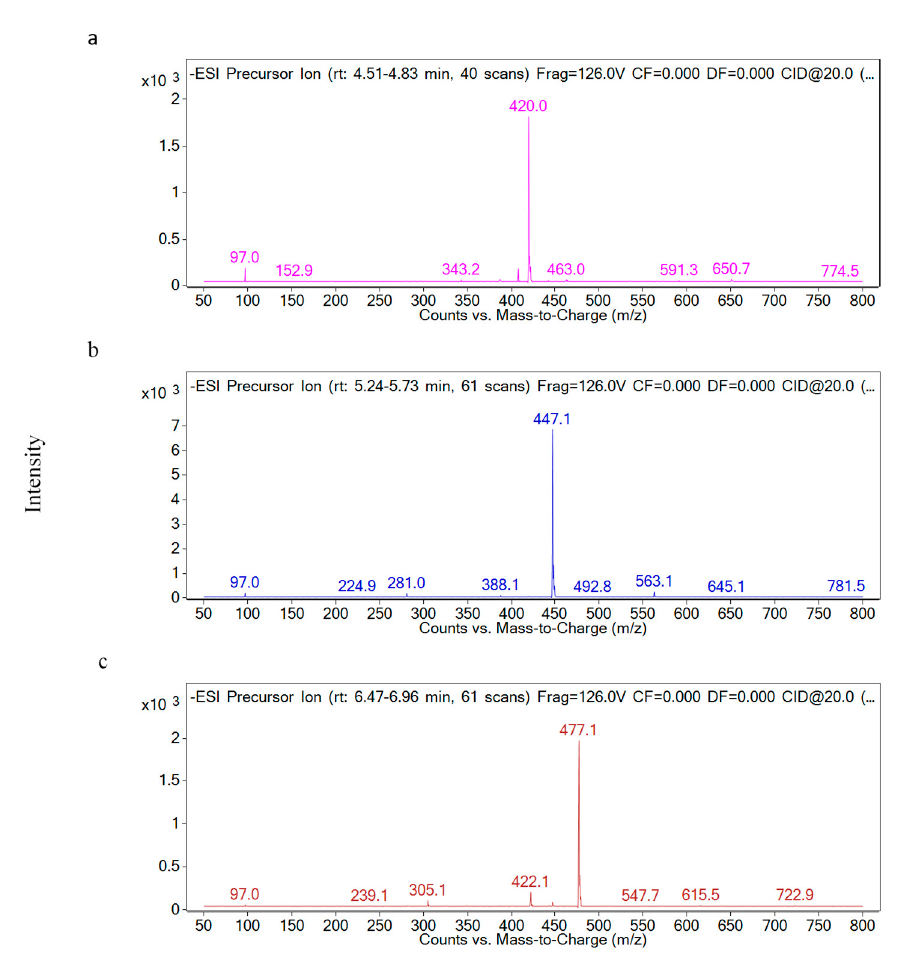
Figure 2. Molecular ion region of electrospray ionization mass spectra of: ( a ) glucoerucin [m/z 420, (M − H) − ]; ( b ) gluco- brassicin [m/z 447, (M − H) − ]; ( c ) 4-methoxy glucobrassicin and neoglucobrassicin [m/z 477, (M − H) − ].